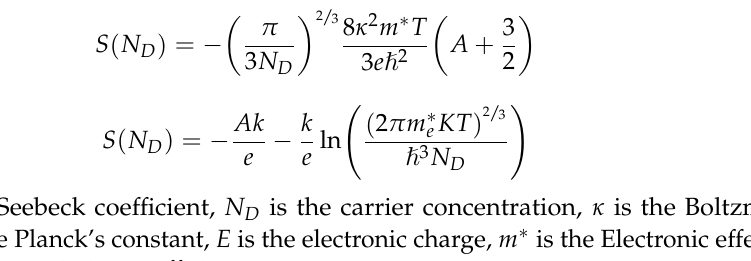
Seebeck Coefficient at